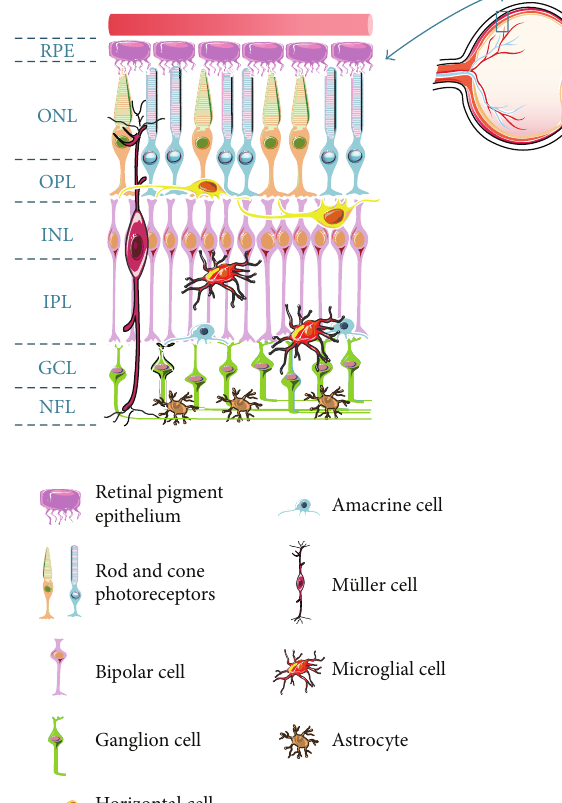
Figure 1: Schematic representation of the major retinal cell types and their organization in the retina. The outermost part of the retina is the retinal pigment epithelium (RPE), which consists of a monolayer of cuboid, pigmented cells between the photoreceptors and the choroid. The retina is divided into three laminar layers: the outer nuclear layer (ONL), the inner nuclear layer (INL), and the ganglioncelllayer(GCL).Thenucleiofrodandconephotoreceptors are located in the ONL. The INL comprises the nuclei of the bipolar, horizontal, and amacrine cells. Cell bodies of the retinal ganglion cells are present in the GCL, and their axons form the nerve fiber layer (NFL), just beneath the GCL. Synapses between photoreceptors and interneurons are located in the outer plexiform layer (OPL) and interneurons synapse with RGC in the inner plexiform layer (IPL). M¨uller cells span all retinal layers. Microglia are mainly found in IPL and GCL, whereas astrocytes are located near the